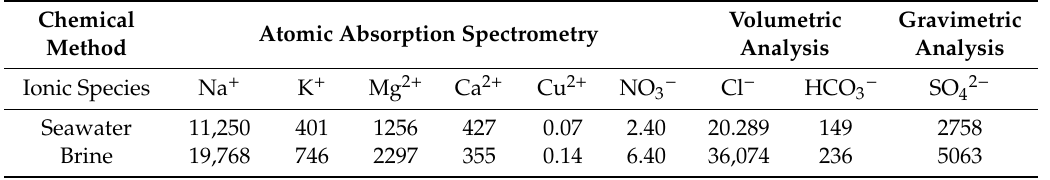
Table 2. Chemical composition of seawater and brine (mg/L).